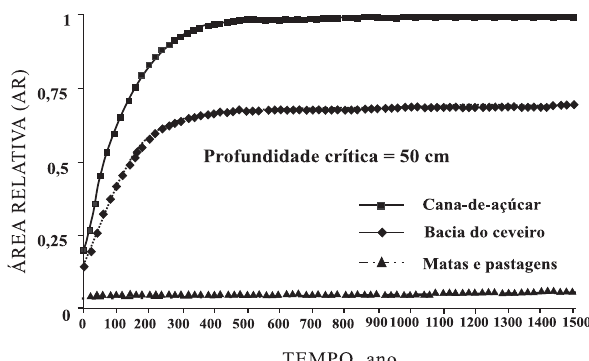
Figura 6. Gráfico do tempo de vida em anos para as áreas com cana-de-açúcar, com outros usos e para a área de estudo como um todo, considerando a profundidade crítica de 50 cm.